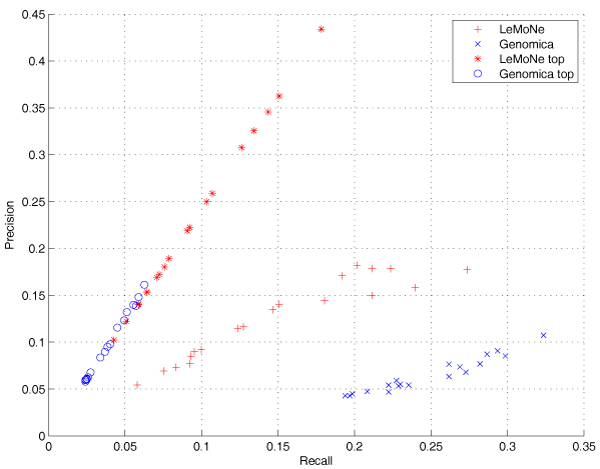
Comparison of heuristic search methods. Comparison of heuristic search methods by recall – precision pairs for data sets with 100 experiments and different noise levels, for the complete module network, and for the subnetwork generated by the top regulators in the regulation programs.